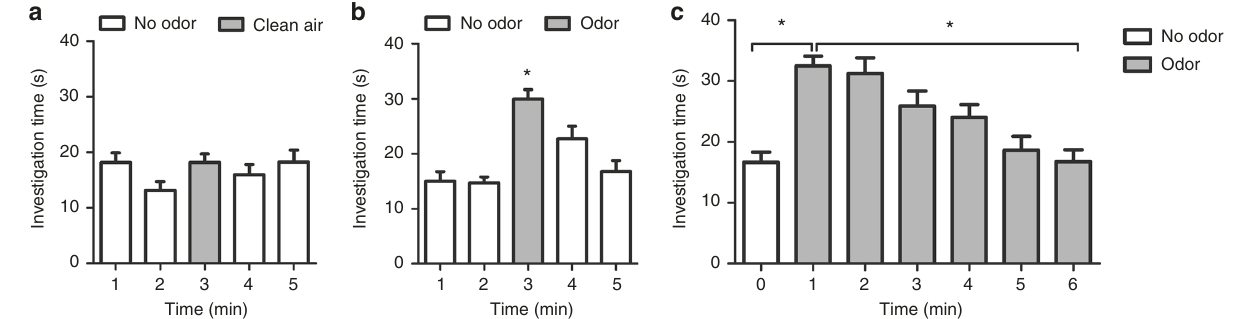
Fig. 3 Olfactory investigation behavior increases with odor onset and habituates over time. a Investigation time (seconds) is not affected when odor is not present, but b increases with odor (10% ethyl butyrate) onset ( n = 10 mice). c Investigation time in control mice increases with odor onset and decreases over the exposure ( n = 10 mice). Error bars = s.e.m., * p